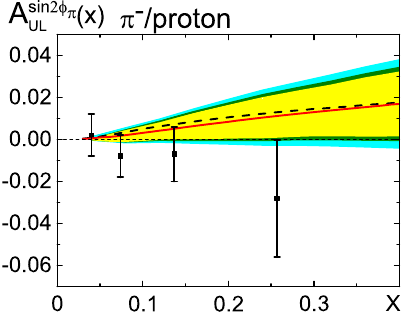
turbative form factor. The yellow, green and cyan shaded areas around solid lines show the uncertainty bands determined by the uncertainties of the parameters in the BDPRS parametrization, the transversity dis- ⊥ ( 1 ) ( x ) , and twist-3 Collins FF H ( 3 ) respectively. tribution h 1 ( x ) for h 1 L The solid squares represent the HERMES data [37,50] for